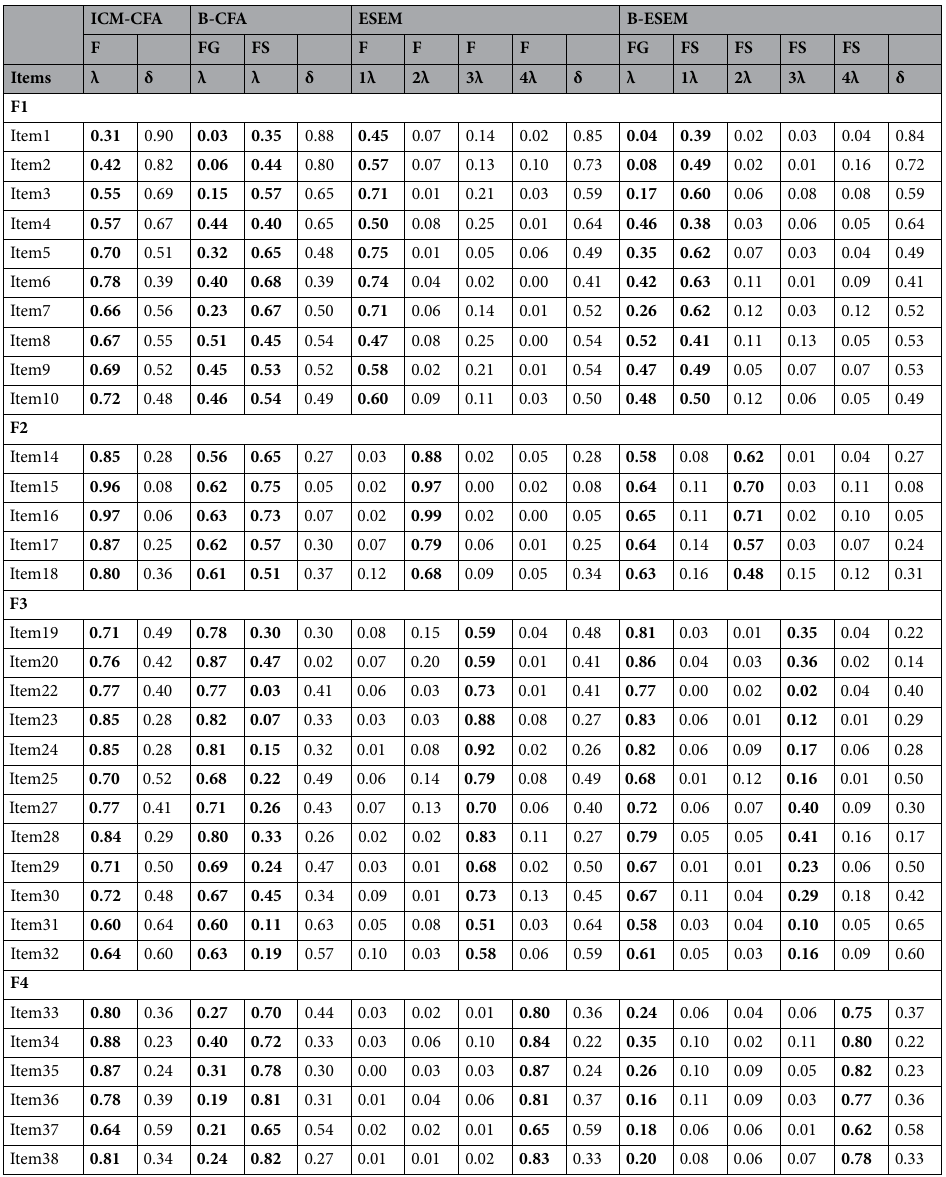
Table 4. Standardized parameter estimates from the alternative measurement models. Main a priori factor loadings are bolded; ICM, Independent cluster model; CFA, Confirmatory factor analysis; B, Bifactor model; ESEM, Exploratory structural equation modelling; λ, Standardized factor loading; δ, Standardized uniqueness; FG, Global factor from a bifactor model; FS, Specific factor from a bifactor model. F1, inherent ideology; F2, aesthetic feelings; F3, avoidance behaviour; F4, policy